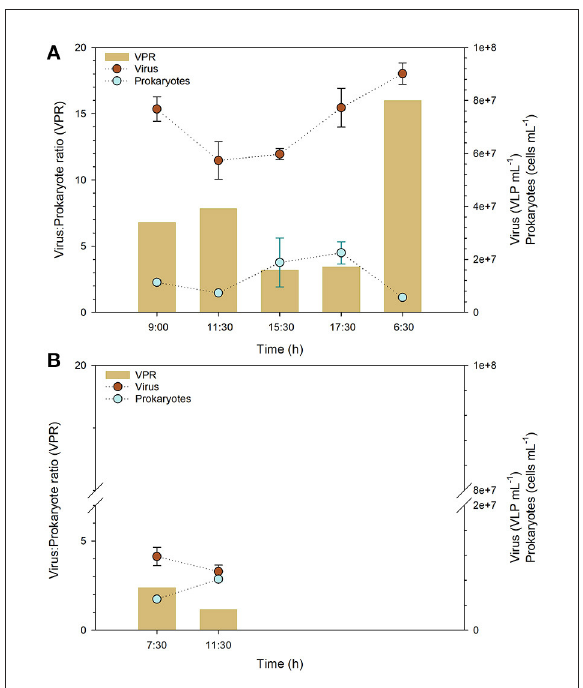
FIGURE3 Viral and prokaryotic abundance and virus to prokaryote ratios (VPR) in two ponds sampled in Salar de Huasco (September 16-17th, 2019), (A) PR and (B) PV. Error bars represent the standard